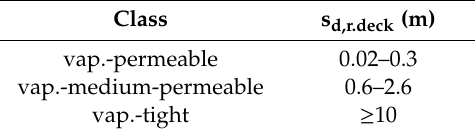
Table 3. Classes of the roof-deck equivalent air layer thickness.